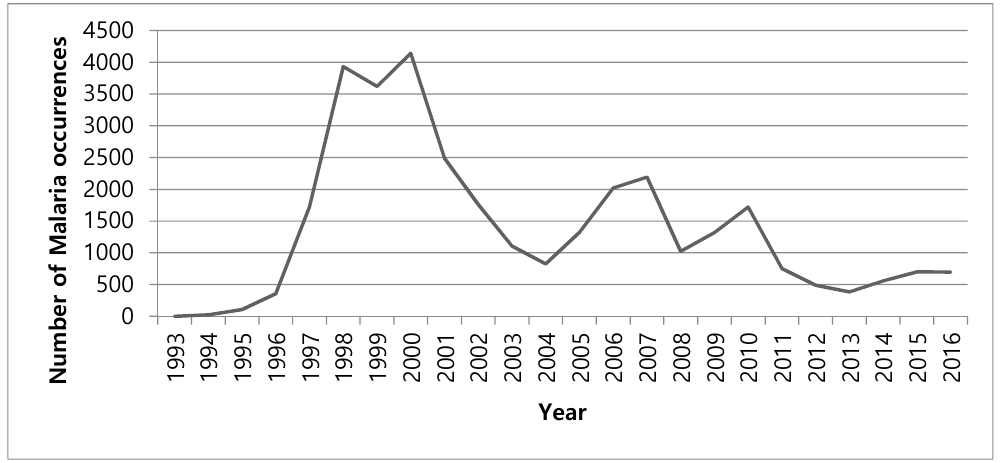
Figure 1. Number of malaria occurrences in Korea since its re-emergence.